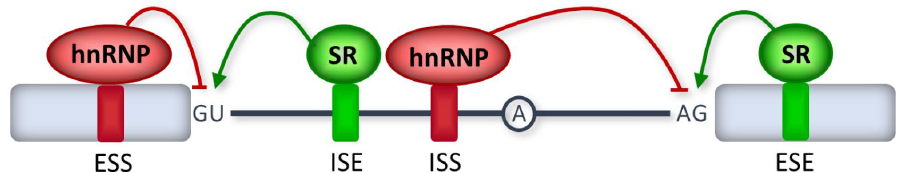
Figure 3. Splicing regulatory sequence elements. Regulatory elements are located in exons (exonic splicing enhancer (ESE) or exonic splicing silencer (ESS)) and in introns (intronic splicing enhancer (ISE) or intronic splicing silencer (ISS)). Enhancers (green) bind SR proteins and promote spliceosome assembly at nearby splice sites. Silencers (red) bind members of the heterogeneous nuclear ribonucleoprotein (hnRNP) family and inhibit spliceosome assembly.